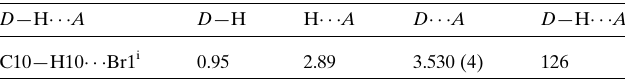
Table 1 Hydrogen-bond geometry (A˚ , (cid:3) ).